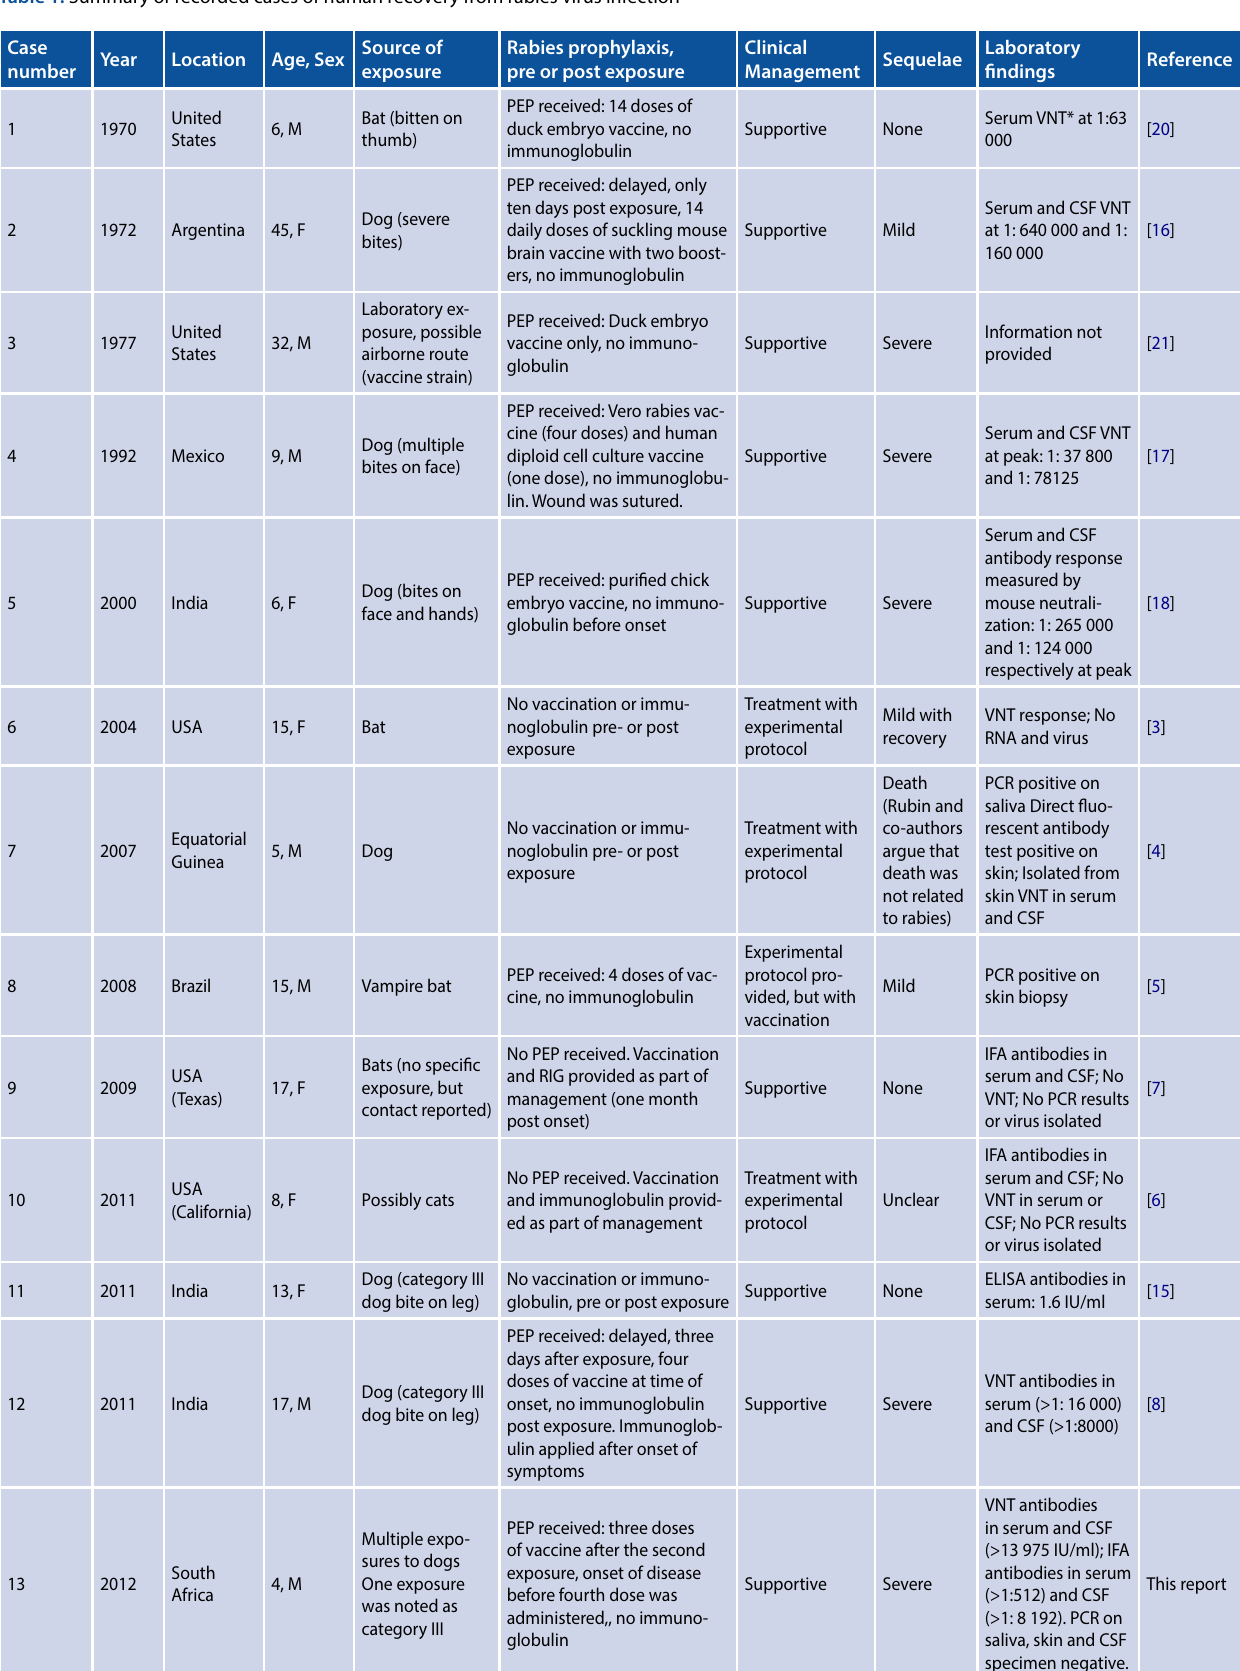
Table 1: Summary of recorded cases of human recovery from rabies virus infection